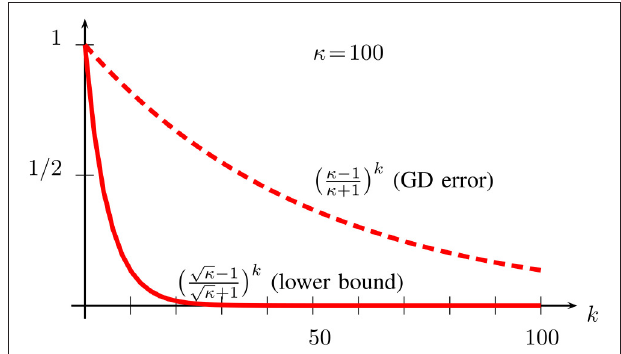
FIGURE 3 | Programming model underlying a FOM. FIGURE 4 | Upper bound (28) on convergence rate of GD and lower bound